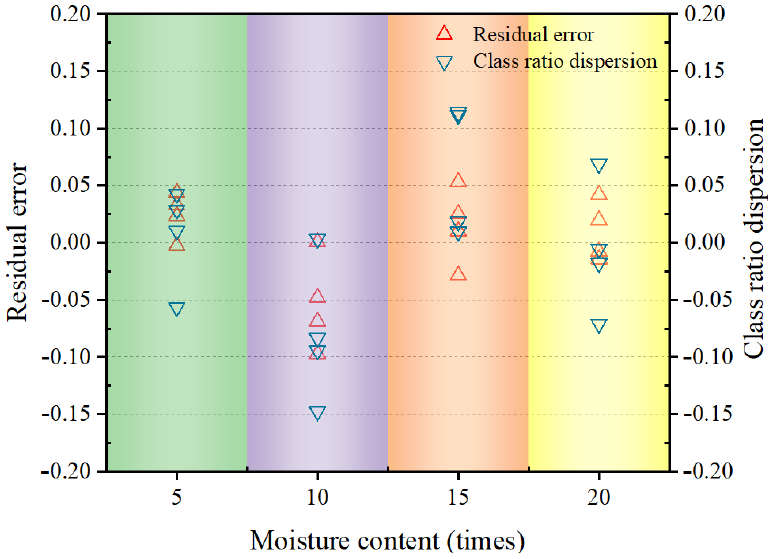
Figure 8. Residual error and class ratio dispersion for each prediction